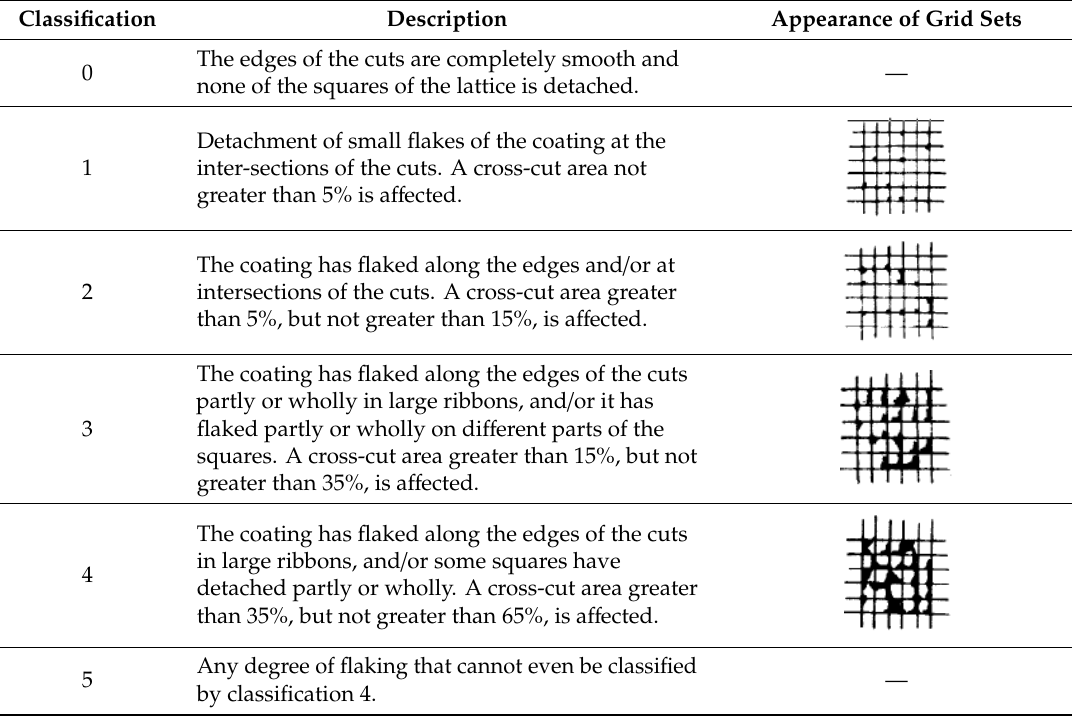
Table 1. Evaluation criterion according to ISO 2409.